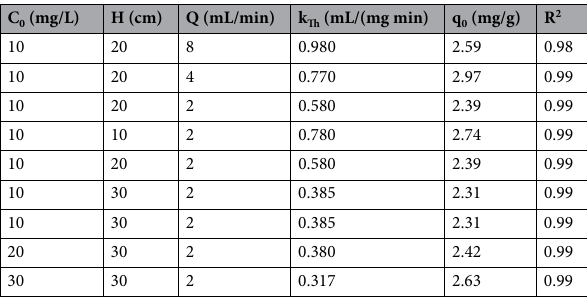
Table 6. Thomas model parameters at different